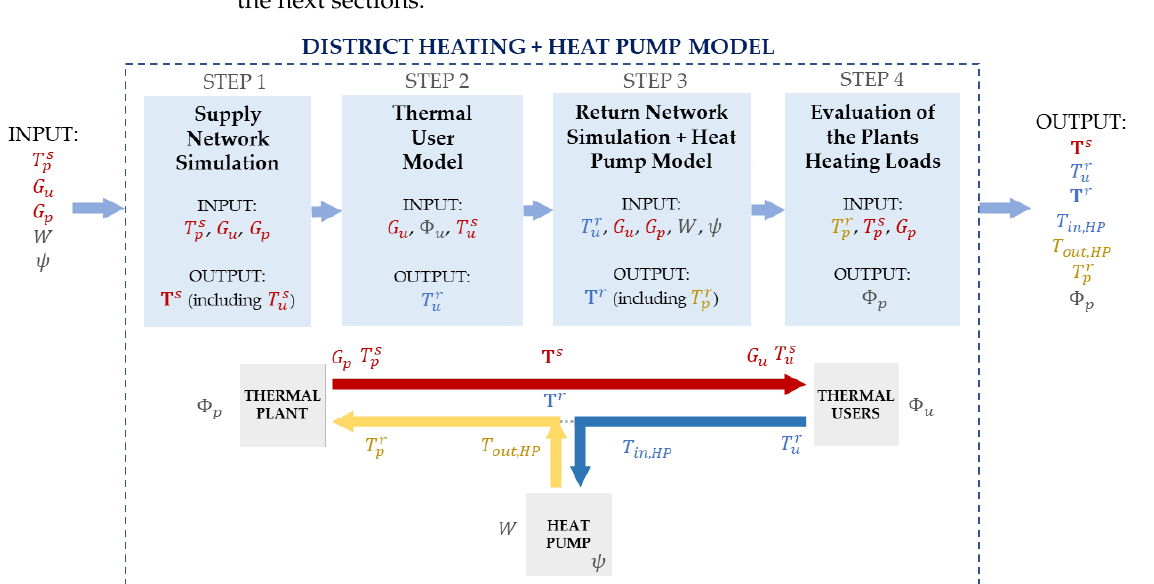
Figure 4. Flow chart of the model including thermo-fluid dynamic simulation of DHN and a model of the heat pump. For clarity, just single elements are represented (thermal plant, supply line, return line, thermal users, heat pumps).